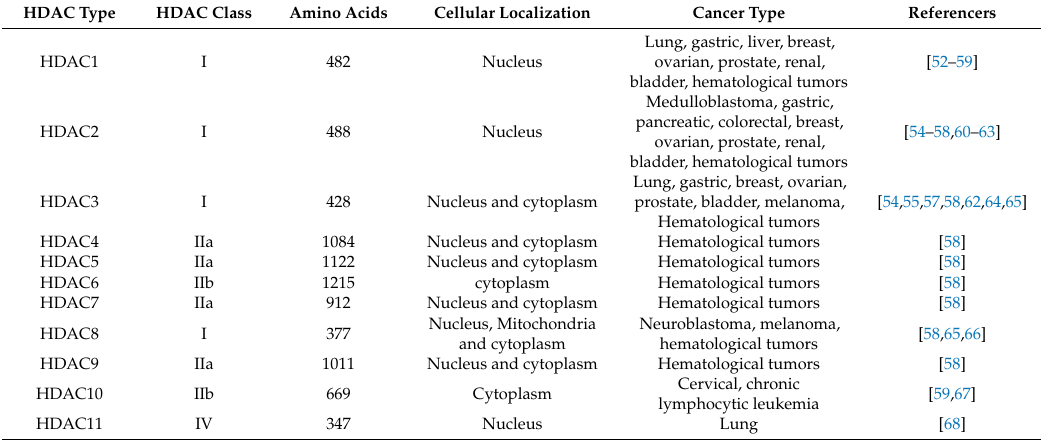
Figure 2. Schematic organization of the HDAC classes I, II and IV showing the Zn 2 + -dependent catalytic domains in blue, the NAD + -dependent catalytic domains in pink, the nuclear localization in yellow and the ubiquitin-binding domain of HDAC6 in orange. Table 1. Type, class, protein size and localization of histone deacetylases